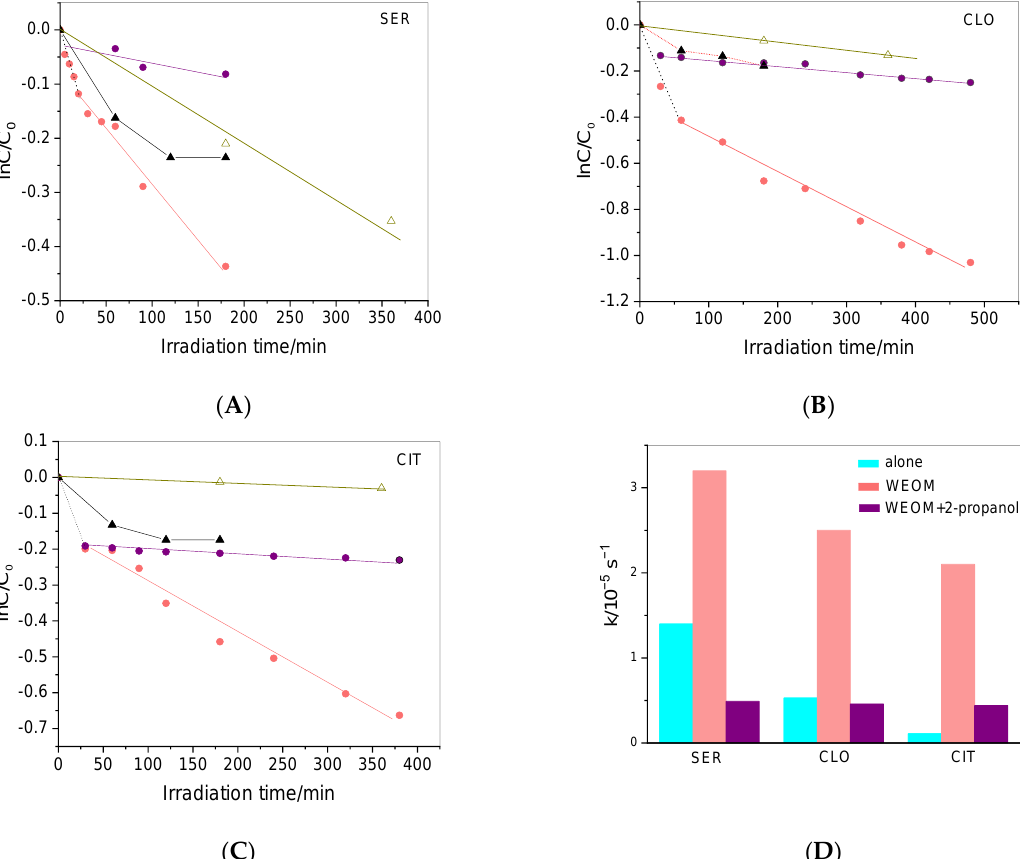
Figure 3. Photodegradation of SER ( A ), CLO ( B ) and CIT ( C ) (5 × 10 − 6 M) in purified water buffered at pH 7 ( (cid:52) ), in the presence of WEOM (5 mgC L − 1 ) ( • ) and in the presence of WEOM (5 mgC L − 1 ) and 2-propanol (5 × 10 − 3 M) ( • ). Dark control experiments ( (cid:78) ). Apparent first order of disappearance of drugs in different conditions ( D